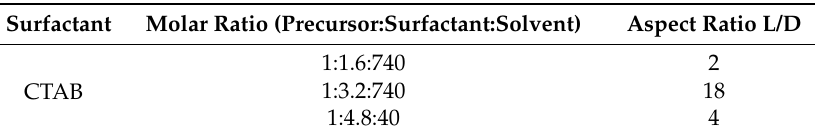
Table 2. Samples using CTAB general synthesis conditions.